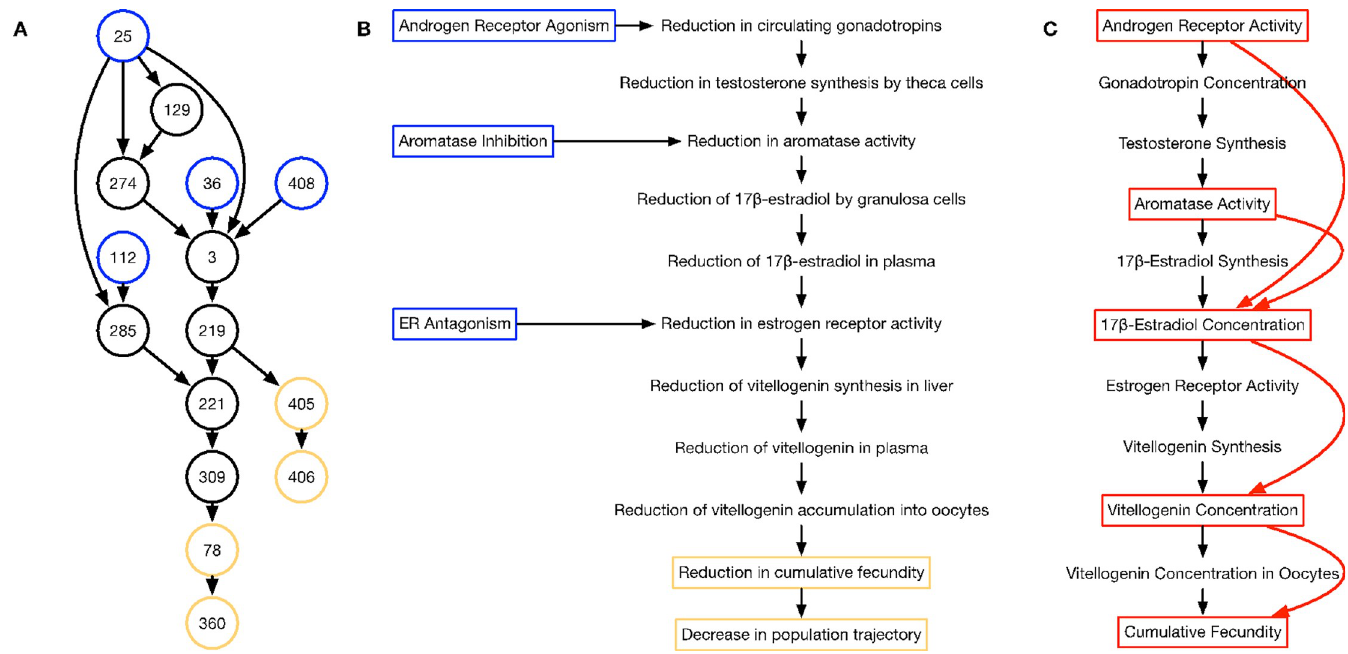
Fig 2. Development of the adverse outcome pathway (AOP) network for female fathead minnow reproductive systems. (A) Diagram of the interactions of various events in the compiled network of 4 AOPs. Blue nodes are molecular initiating events, black nodes are key events, and yellow are adverse outcomes. Numbers represent the indices of the events in the AOPwiki. Information on each node is available at aopwiki.org/events/xxx, where xxx is the index in the node. (B) Diagram of the curated AOP network presented in panel A with indirect interactions removed and events with the same functional consequences collapsed into a single node. (C) Diagram of the quantitative model based on the curated AOP network presented in panel B. Highlighted in red are the nodes for which we have obtained data, with the dose/dose response relationships indicated by red arrows.